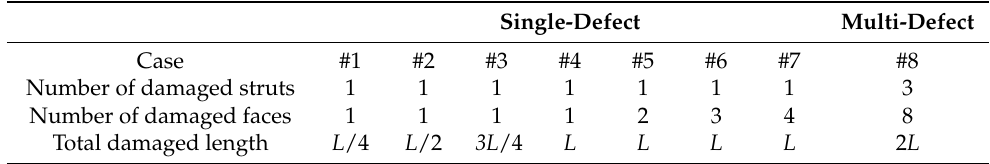
Table 4. Summary of experimental test